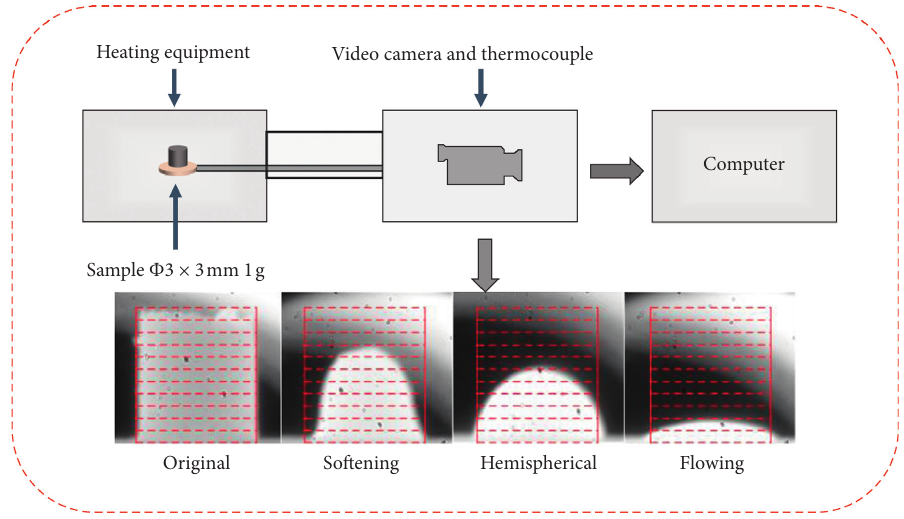
Figure 2: Diagrammatic chart of melting temperature experiment.